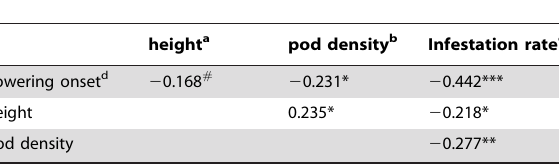
Table 3. Spearman’s rank order correlation coefficients between four main traits of Ulex europaeus plants grown in the common garden.